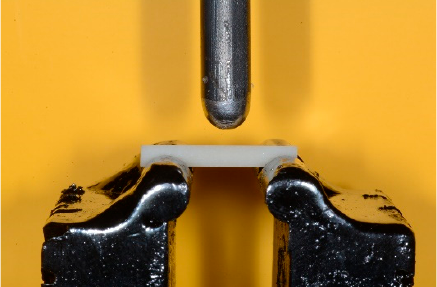
Figure 1. Image of the support realized for the execution of three-point bending tests, following the specifications suggested by ISO6872. specifications suggested by